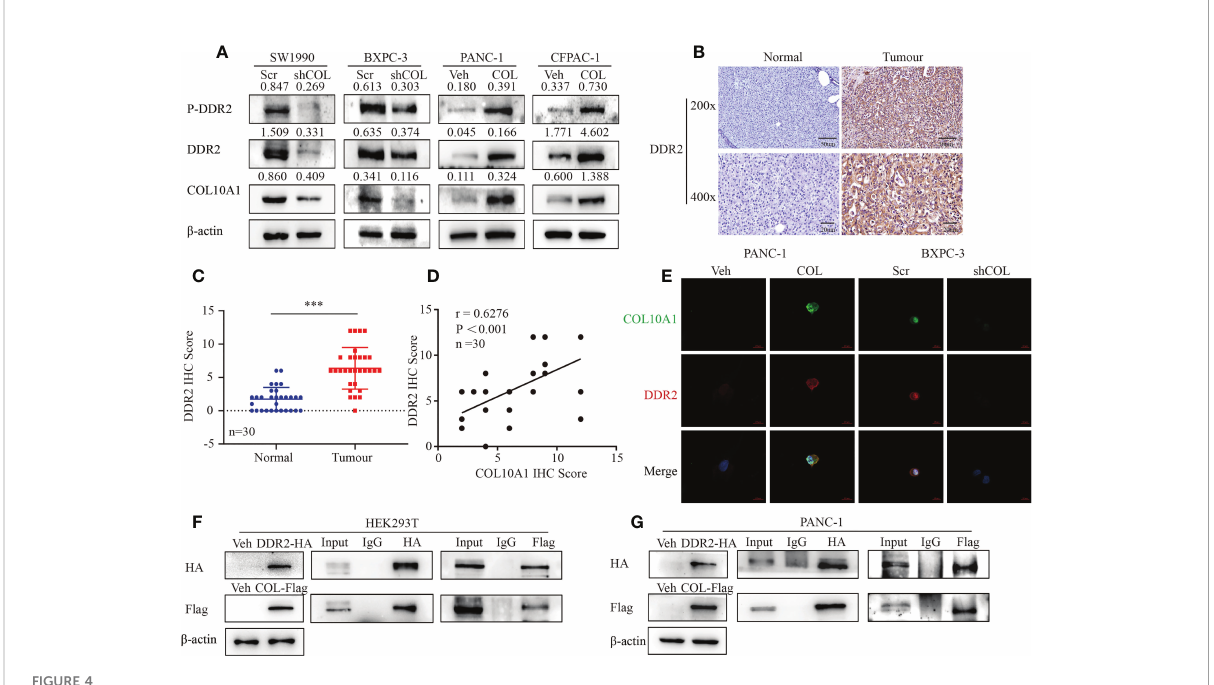
FIGURE 4 COL10A1 regulates DDR2 expression in PDAC cells. (A) Western blot results showed the effect of COL10A1 on DDR2 and P-DDR2 protein levels. (B) IHC staining of DDR2 in PDAC and normal pancreatic tissues. The scale bar at 200× magni fi cation represents 20 µm. The scale bar at 400× magni fi cation represents 50 µm. (C) DDR2 IHC scores were differentially expressed between the normal and tumor groups. n = 30. Two-tailed Student ’ s t-test. (D) Pearson correlation analysis was conducted to analyze the relation between COL10A1 and DDR2 in 30 PDAC tissues. (E) Co-localization of COL10A1 and DDR2 in PDAC cells detected by immuno fl uorescence. (F, G) The detection of the interaction between COL10A1 and DDR2 by Co-IP. *** P